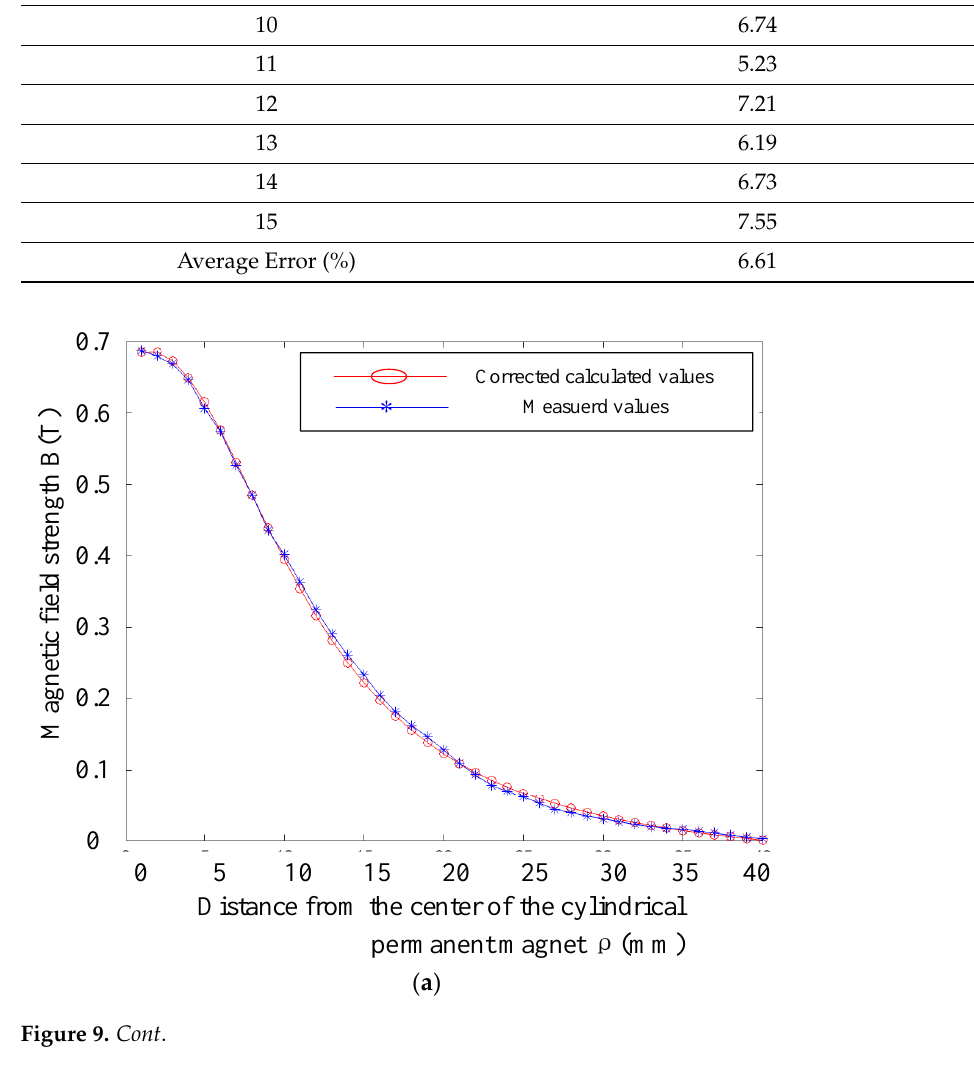
Table 4. Modified calculation error rate table for different distances. Distance from Upper Face (mm)